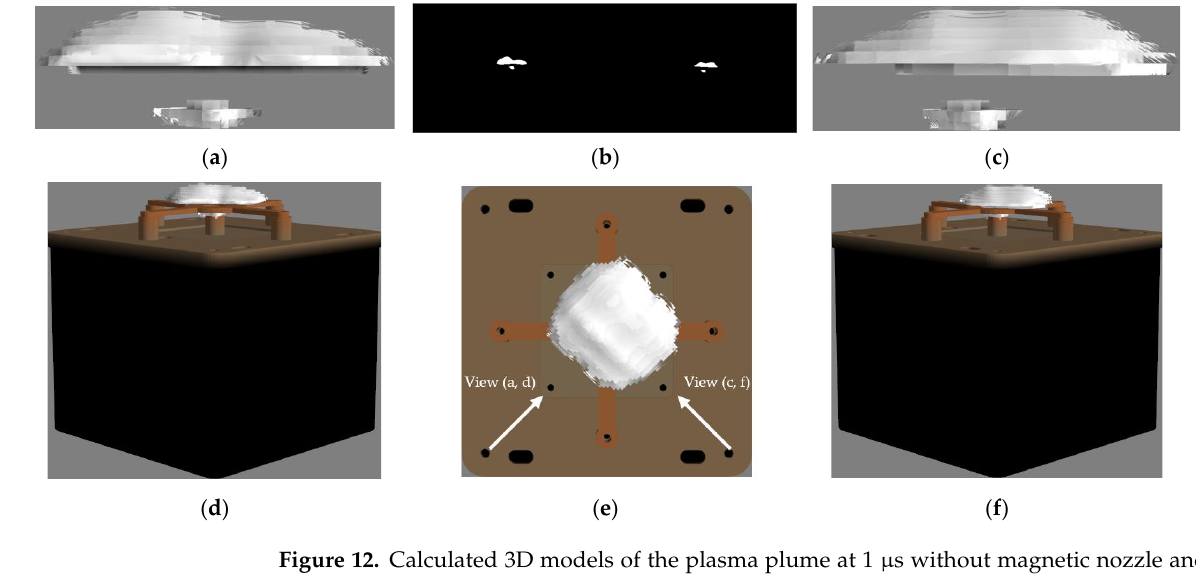
Figure 12. Calculated 3D models of the plasma plume at 1 µs without magnetic nozzle and with the PJP model: ( a ) reconstructed plume left direction of observation; ( b ) recorded image with both directions of observation; ( c ) reconstructed plume right direction of observation; ( d ) isometric view of left direction of observation with PJP; ( e ) front view with PJP; ( f ) isometric view of right direction of observation with PJP.